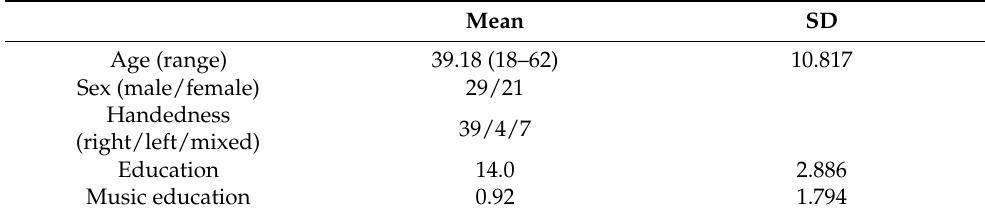
Table 1. Demographic characteristics of